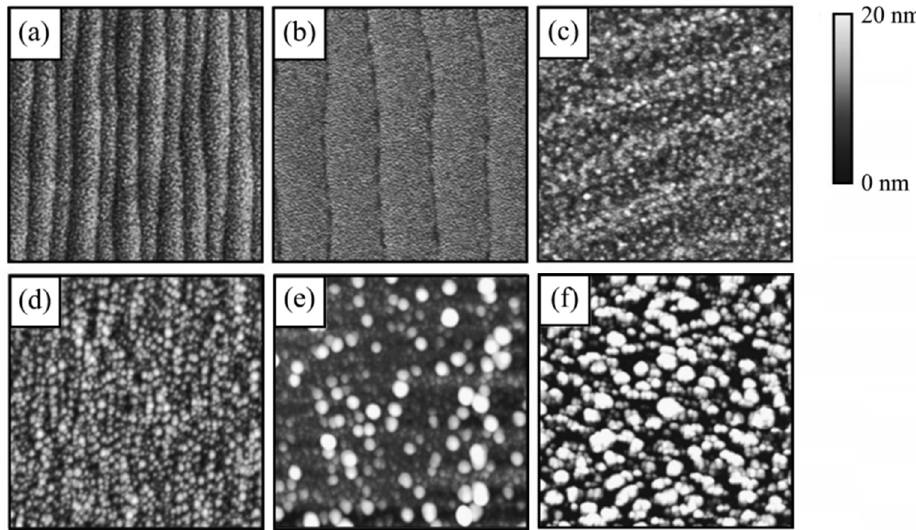
Figure 4. Variation of growth modes of BaTiO 3 films deposited on the SrTiO 3 substrate by AFM. BaTiO 3 changes from layer-by-layer ( a , b ) to island ( c – f ) growth mode. Reprinted with permission from [62] 2002 AIP Publishing.